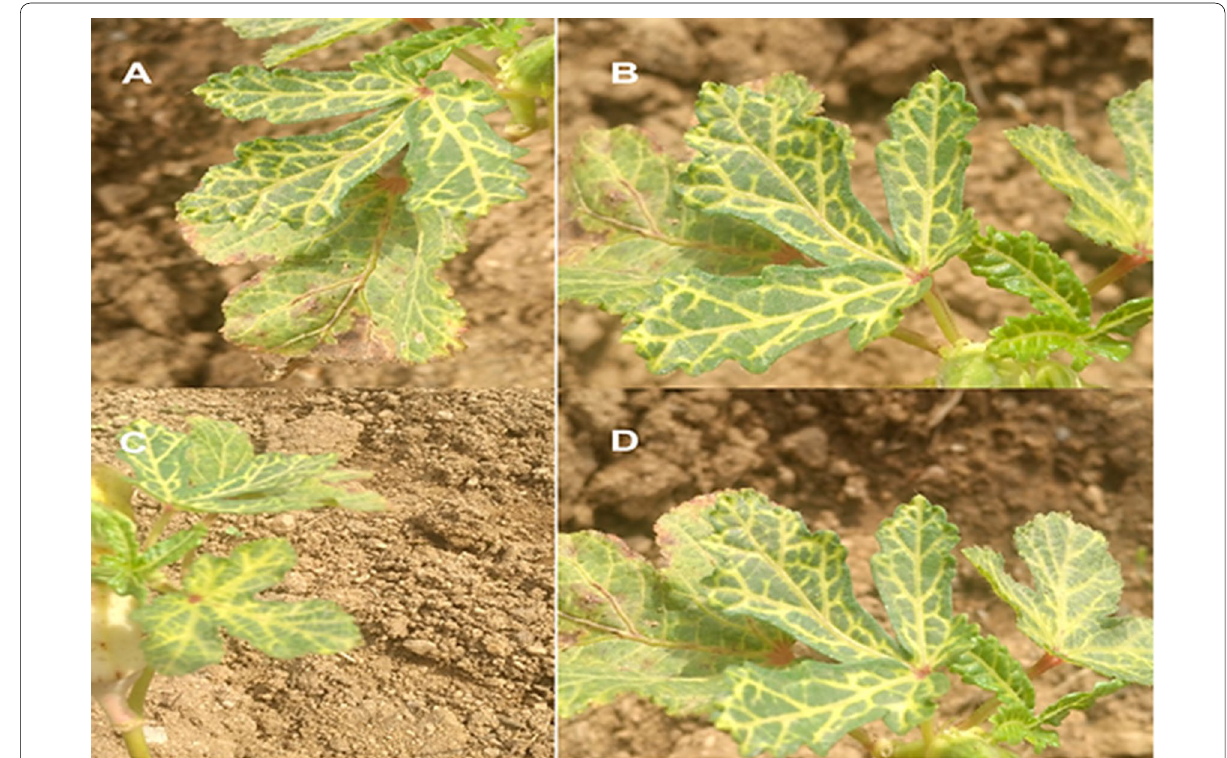
Fig. 1 Infected okra plants collected from okra farm in district Mardan, showing yellow vein and yellow mosaic pattern ( A – D